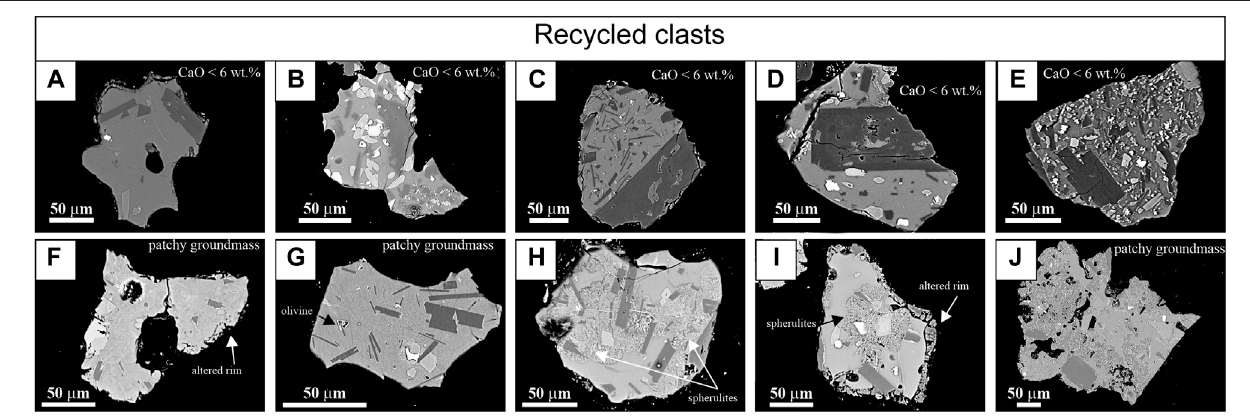
FIGURE 8 | Representative high-resolution BSE-SEM images of recycled clasts. (A – E) Particles characterized by CaO < 6 wt.% content and variable groundmass crystallinity,frommicrolite-free (A) tomicrolite-rich (E) .Someoftheseclastsshowresorbedplagioclaseandpyroxenemicrolites (B,D) .Otherclastsarecharacterizedby groundmass patches with contrasting crystallinity (F,G,J) ; olivine subsolidus transformation (G) ; altered/corroded external rims (F – I) ; occurrence of spherulites penetrating the glass and not affecting the whole groundmass (H,I) .